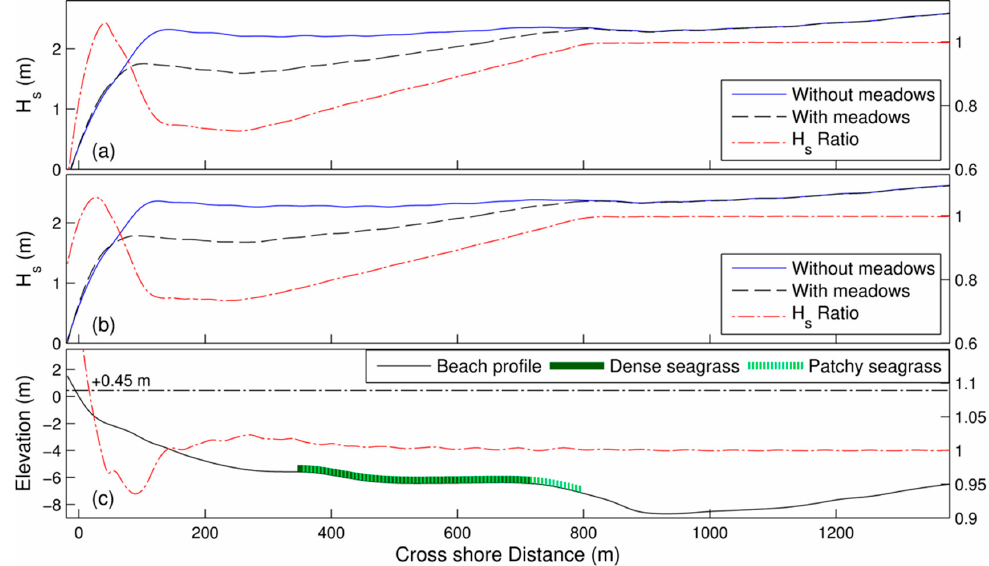
Figure 6. Effects of the shallow seagrass meadows on the wave energy (height). ( a ) Cross-shore wave height and attenuation ratio (Hs ratio, scale at the right axis) due to seagrasses under the present mean sea level. ( b ) Cross-shore distribution of wave height and attenuation ratio under a 0.15 m MSLR coupled with spring tides (+0.3 m). ( c ) Bed profile and cross-shore distribution of the ratio of wave attenuation under an increased sea level (+0.45 m) and the present mean sea level (stippled line,Hs ratio (+0.4)5 /Hs ratio (0.0) , scale at the right axis). Offshore wave height and period modelled, Hrms = 2.8 m and Tp = 8.7 s, respectively. Median sediment size (D50), 0.28 mm. Dense seagrass characteristics as shoot density of 400/m 2 , canopy height of 0.20 m and grass diameter of 0.01 m; patchy seagrass characteristics as 200/m 2 , 0.20 m and 0.01 m, respectively (example on profile 21).